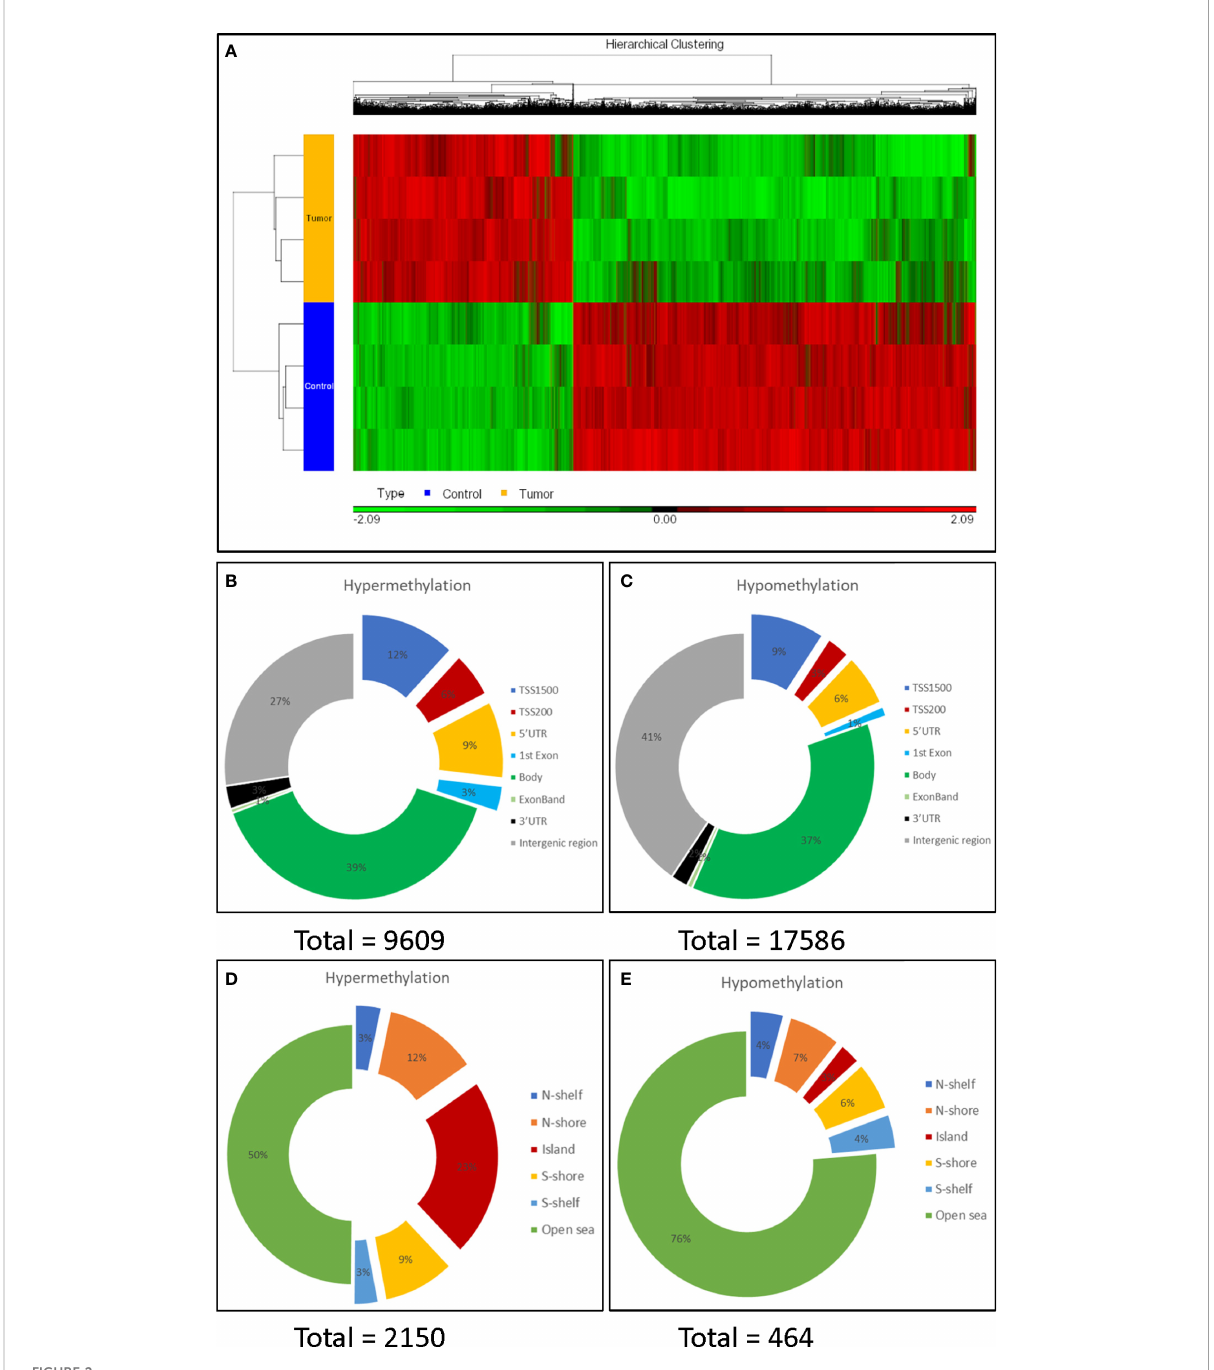
FIGURE 2 Characterization of DNA methylation pro fi ling. (A) Heat map of unsupervised hierarchical clustering of the 27,195 differentially methylated CpG sites. There were more hypo- (green) than hyper-methylated CpG sites (red) in tumors compared to the controls. (B, C) : Distribution of the hypermethylated and hypomethylated CpG sites over genomic elements. (D, E) : Distribution around CpG islands. The CpG island shores ( fl anking 2k bases) and shelves ( fl anking 2-4k base), divided into N (north, or 5 ’ ) and S (3 ’ ); more distant istermed ‘ open sea ’ . Promotor regions were preferentially hypermethylated and half of hypermethylated CpG sites were within (23%) or adjacentto a CpG island (a shelf or shore), while 76% of hypomethylated CpG sites occurred in the open